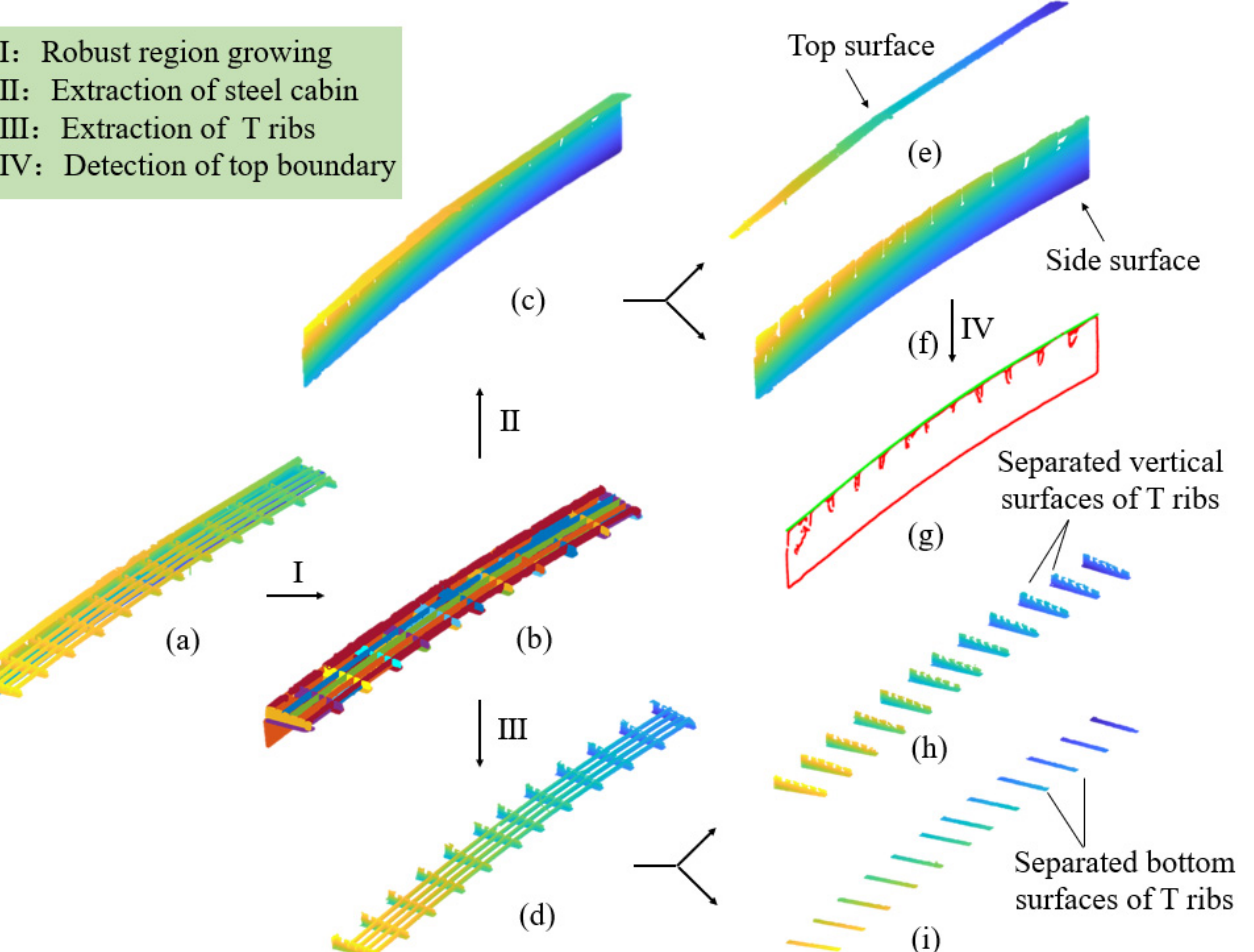
Figure 13. Experimental process for validation experiments: ( a ) preprocessed point clouds of SBGs; ( b ) laser-scanned data cluster classification; ( c ) extracted steel cabin; ( d ) T ribs after the application of the subtraction algorithm; ( e ) top surface of the steel cabin; ( f ) side surface of the steel cabin; ( g ) upper boundary of the steel cabin; ( h ) vertical planes of the T ribs; and ( i ) bottom planes of the T ribs.